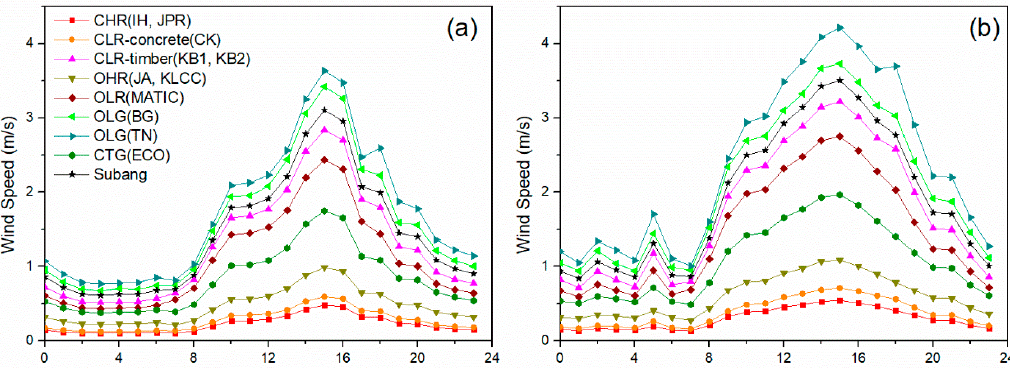
Figure 8. Average diurnal wind speed variation as modelled by ADMS-Urban in wet ( a ) and dry ( b ) seasons for different land use areas.